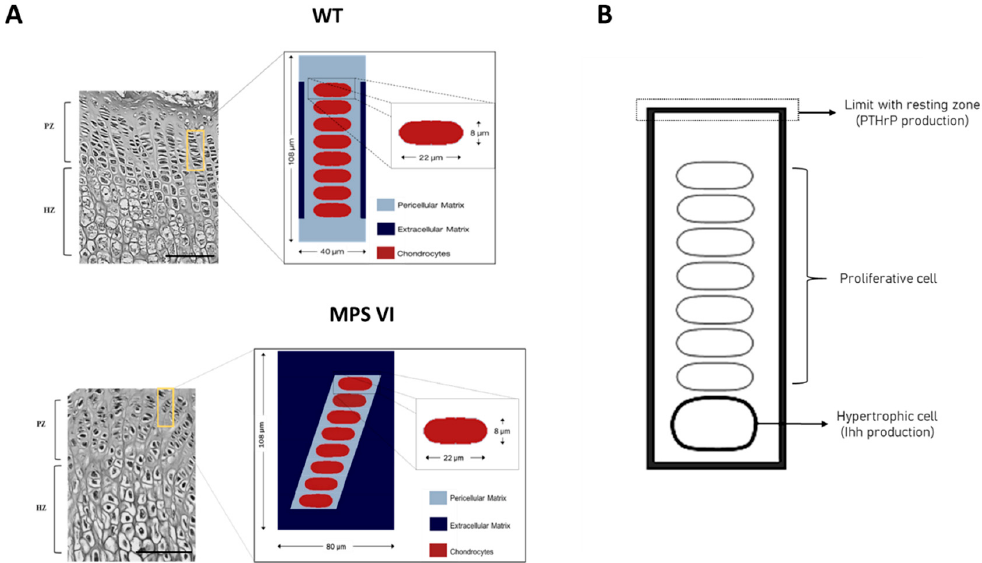
Figure 2. Graphical description of the work domain used in the computational mechanobiological model. ( A ) The model corresponding to wild type animals considers a column of cells perfectly aligned with the growth axis (Image modified from [26]), while for mucopolysaccharidosis type VI (MPS VI) animals it is considered misaligned as indicated in the text and corresponding to experimental findings. Scale bars correspond to 100 µm; ( B ) Localization of the structures responsible for the production of PTHrP and Ihh.